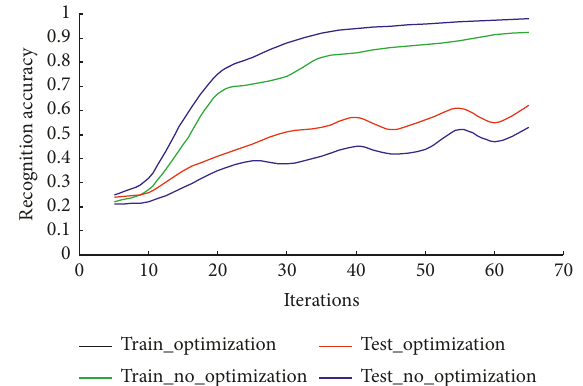
Figure 13: Comparison of accuracy before and after model optimization.